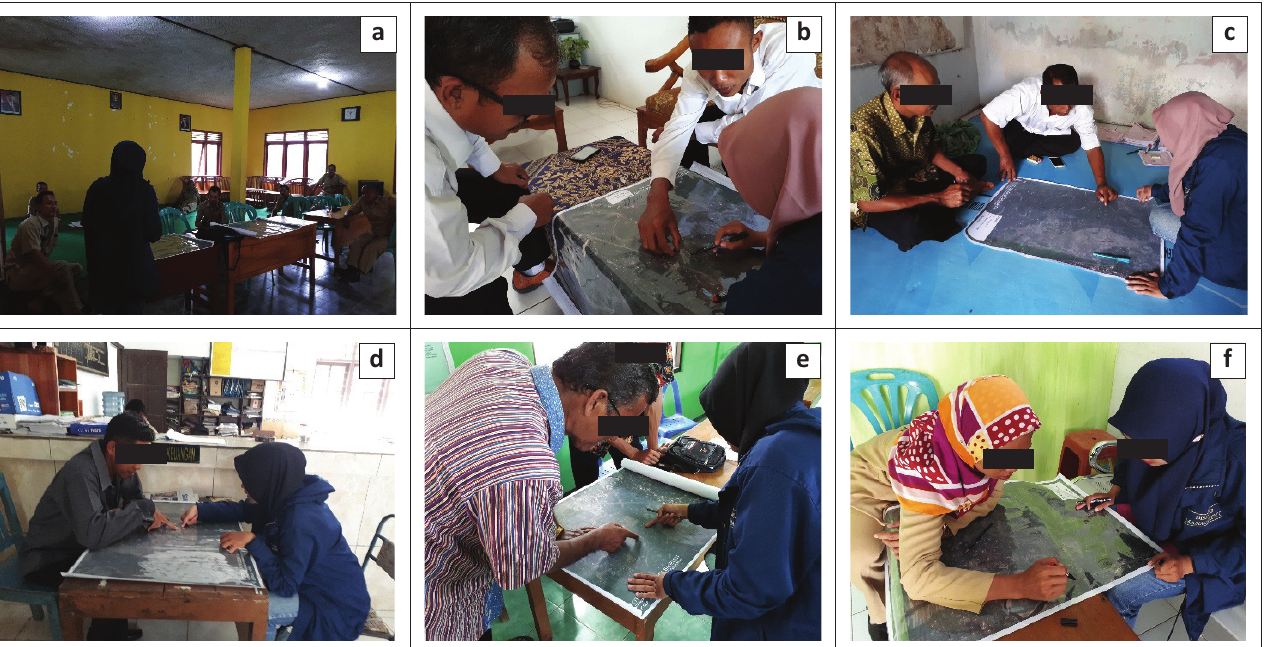
FIGURE 3: Participatory geographic information system in (a) Dadirejo, (b) Bapangsari, (c) Bugel, (d) Krendetan, (e) Bagelen and (f) Kalirejo villages.